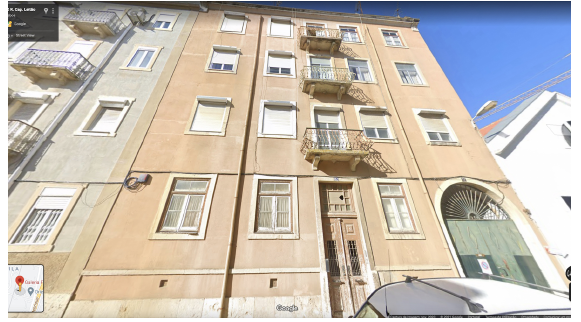
Figure 5. Main façade (Google Maps).